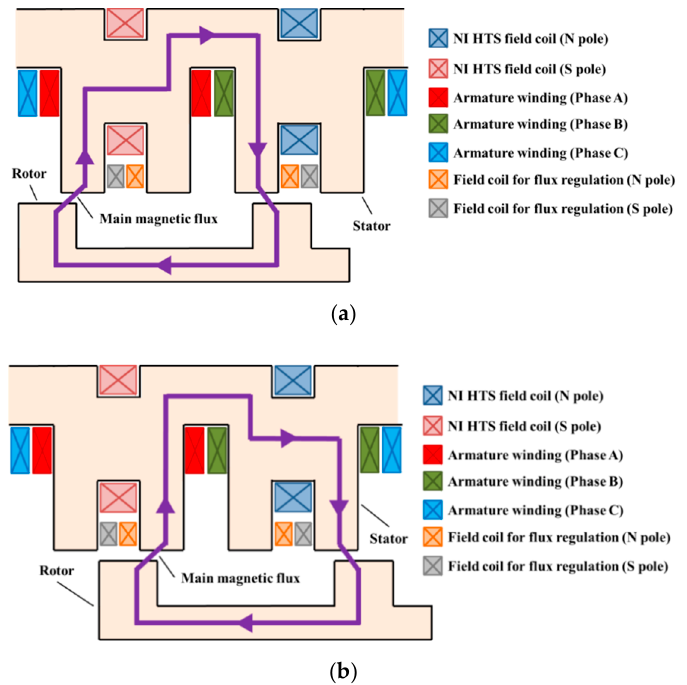
Figure 4. Operating principle: ( a ) starting point, and ( b ) after moving the rotor position by 180 electrical degrees.